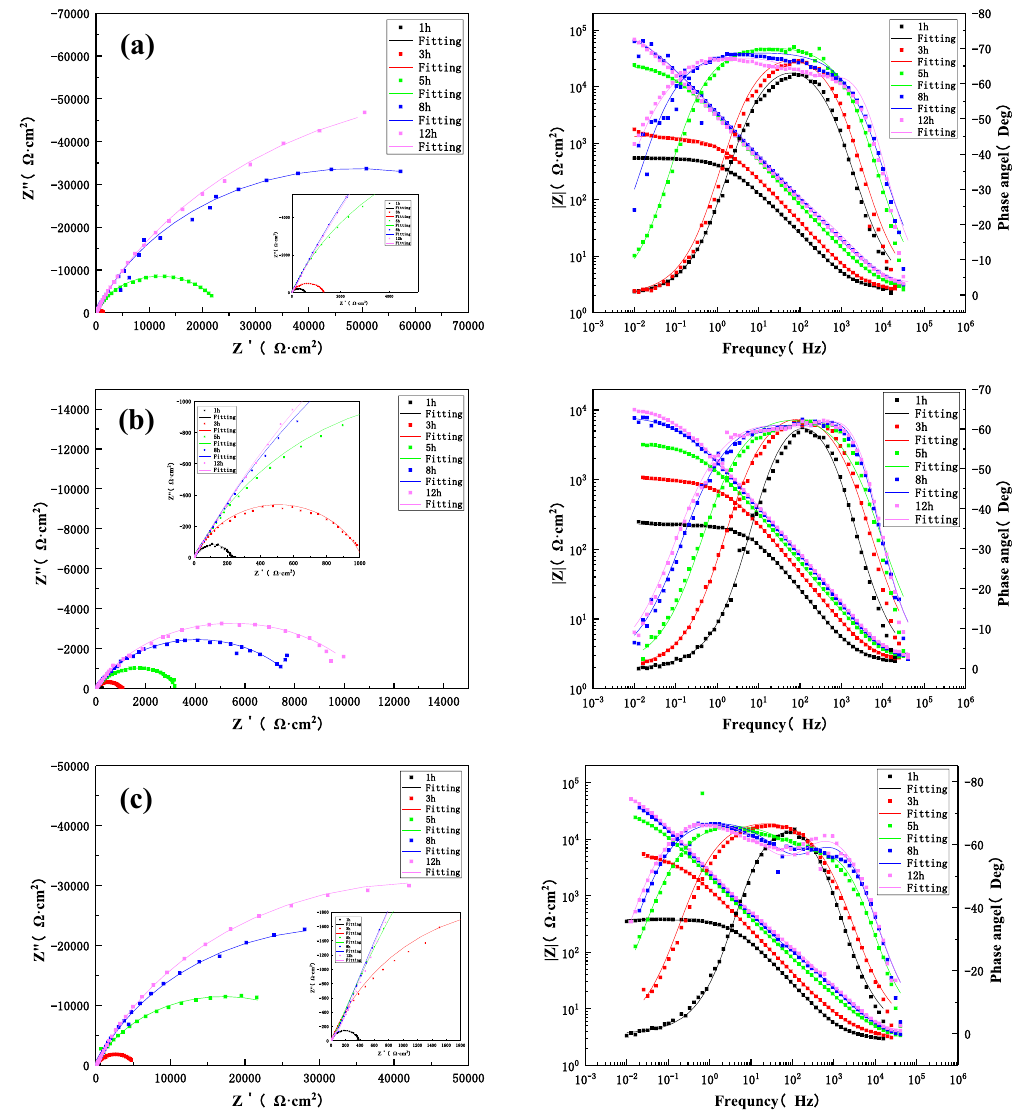
Figure 10. The impedance changes in the WM during 12 h scouring in seawater with three different flow rates: ( a ) 1.85 m/s, ( b ) 3 m/s, ( c ) 6 m/s.